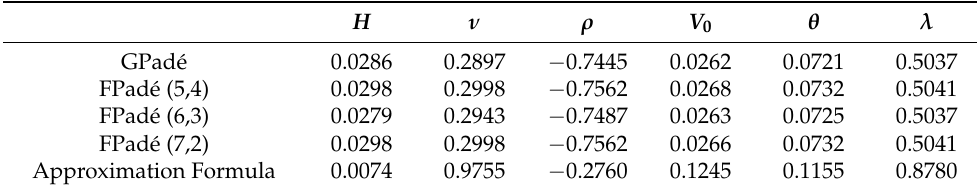
Table 1. Calibration to SPX implied volatility on 18 June 2021. H ν